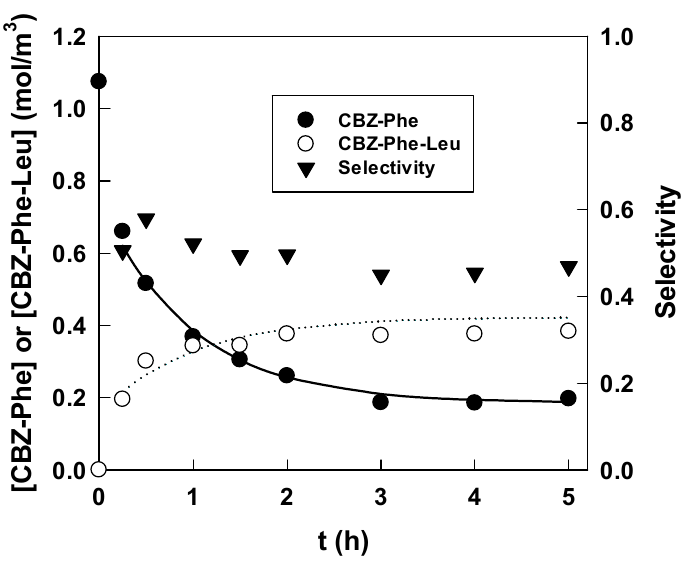
Figure 2. Time courses of Cbz-Phe and Cbz-Phe-Leu concentrations, and selectivity ( w 0 = 28, pH 5, DCC = 7 mol/m 3 ). Solid and dotted lines were calculated from the rate constants and selectivity.